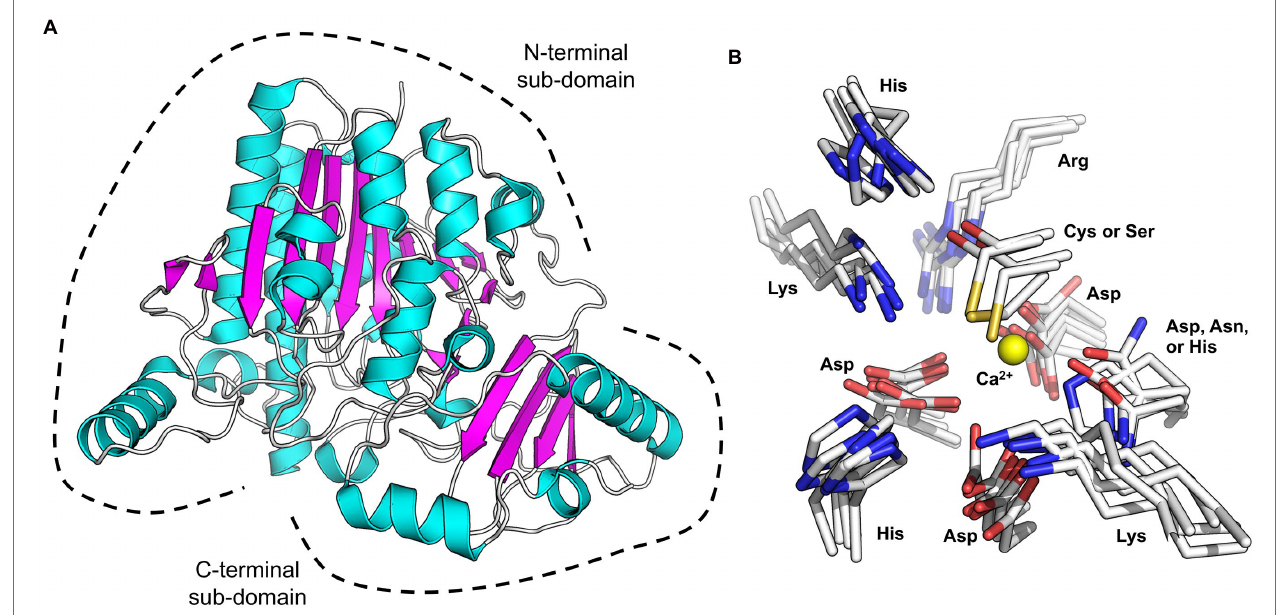
FIGURE 1 | X-ray crystal structure showing the canonical sulfatase family S1 structure. (A) Representative marine sulfatase (PfS1_19A PDB ID: 6BIA; Hettle et al., 2018) characterised by two sub-domains of mixed α / β topology ( α -helices coloured purple; β -sheets coloured cyan). Dashed line designates the secondary structure motifs comprising the N- and C-terminal sub-domains. (B) Structural overlay of the reported marine carbohydrate-specific sulfatase structures, of marine origin, from Table 1 highlighting the conserved residues comprising the sulfatase signature sequence motif. Only the calcium ion from the PfS1_19A structure is represented, shown as a yellow